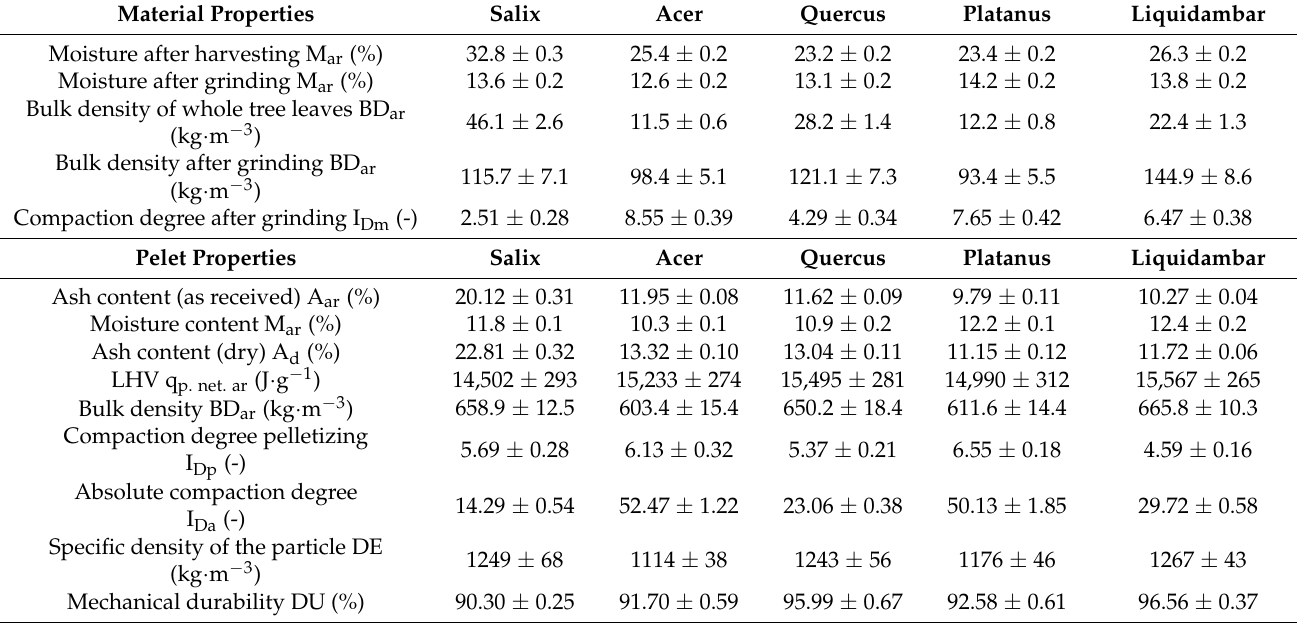
Table 3. Characteristics of raw materials and pellets - mean values and standard deviations ( ±